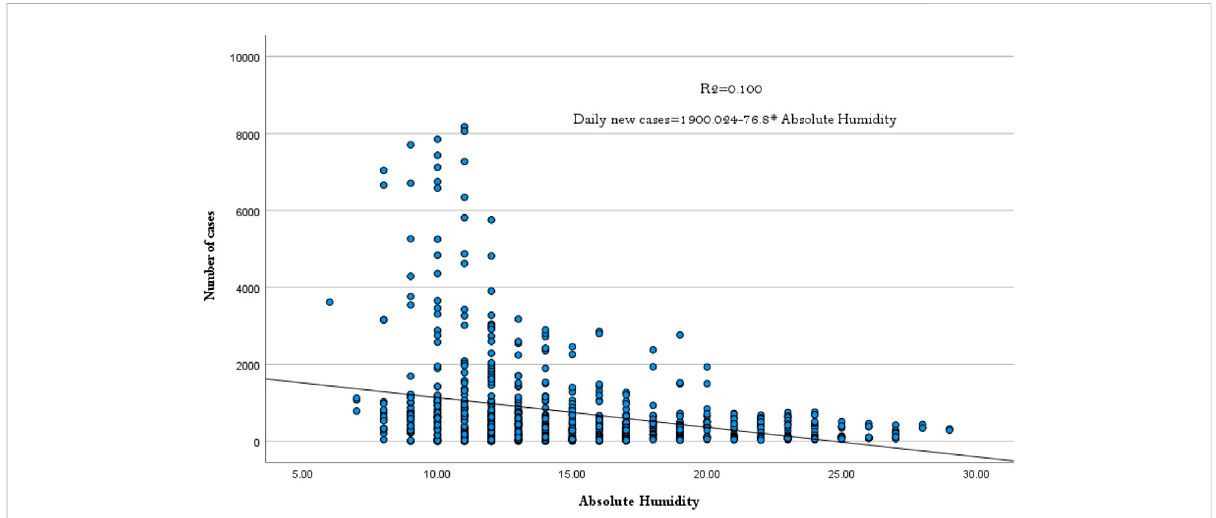
FIGURE 11 Scatter diagram and simple regression line presenting the relationship between new daily cases of SARS-CoV-2 and mean average absolute humidity in Bahrain for 27 months of recorded cases.